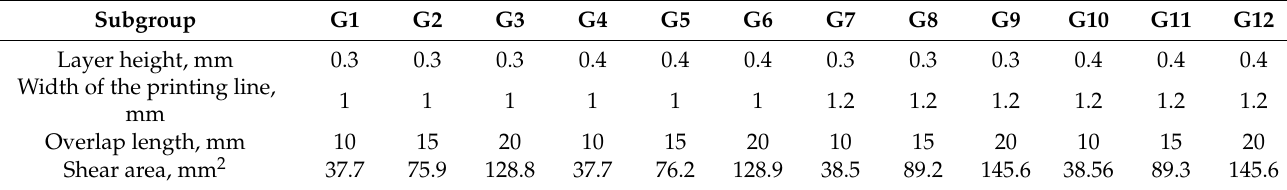
Table 2. Subgroups of the printed specimens with nine lines.